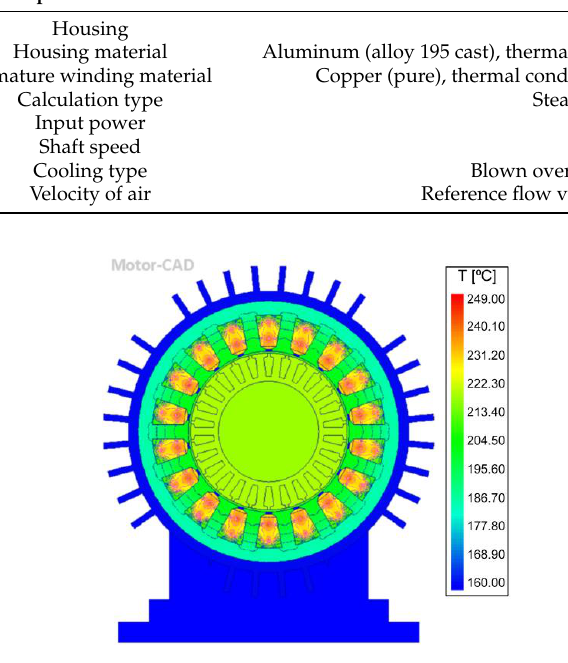
Figure 8. Radial view of motor (fan-cooled) after FEM analysis.